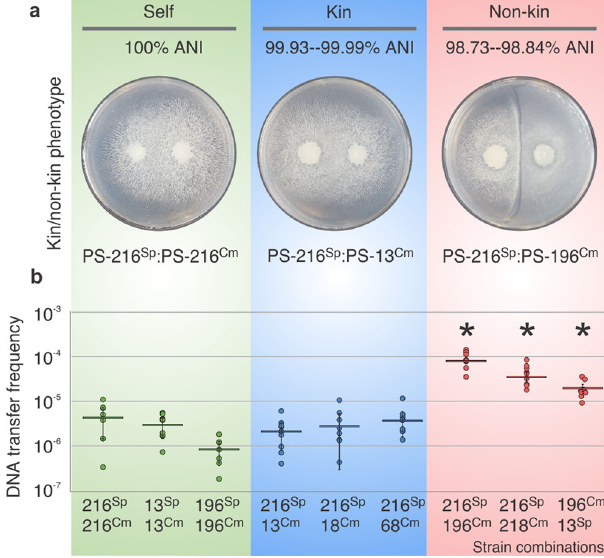
Fig. 1 Transformation frequency as a function of genomic relatedness between strains. a Representative interactions of control self-interaction (green), kin interaction (blue) and non-kin interaction (red) (ANI indicated). b Transformation frequency as quanti fi ed by the frequency of double mutants isolated from the swarm boundary ( n = 3 biologically independent experiments, each n performed in three technical replicates (9 data points), error bars represent SD). Asterisks represent statistically signi fi cant values compared to corresponding self and kin pairings (two tailed Student ’ s t- test for unpaired data assuming equal variances), (Supplementary Notes and Supplementary Fig. 2). Data are presented as mean values ± SD and error bars represent SD of the mean values ( n = 3). For strain abbreviations see Table